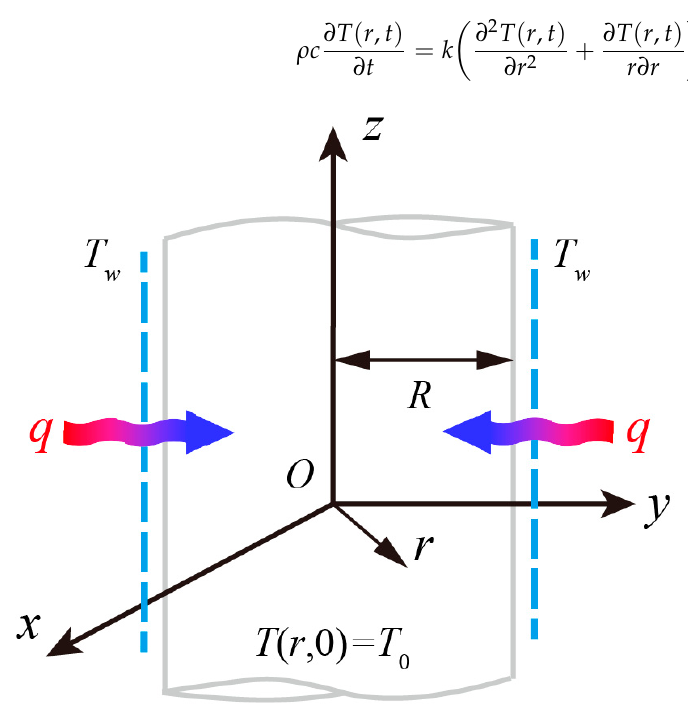
Figure 4. Schematic diagram of one-dimensional heat